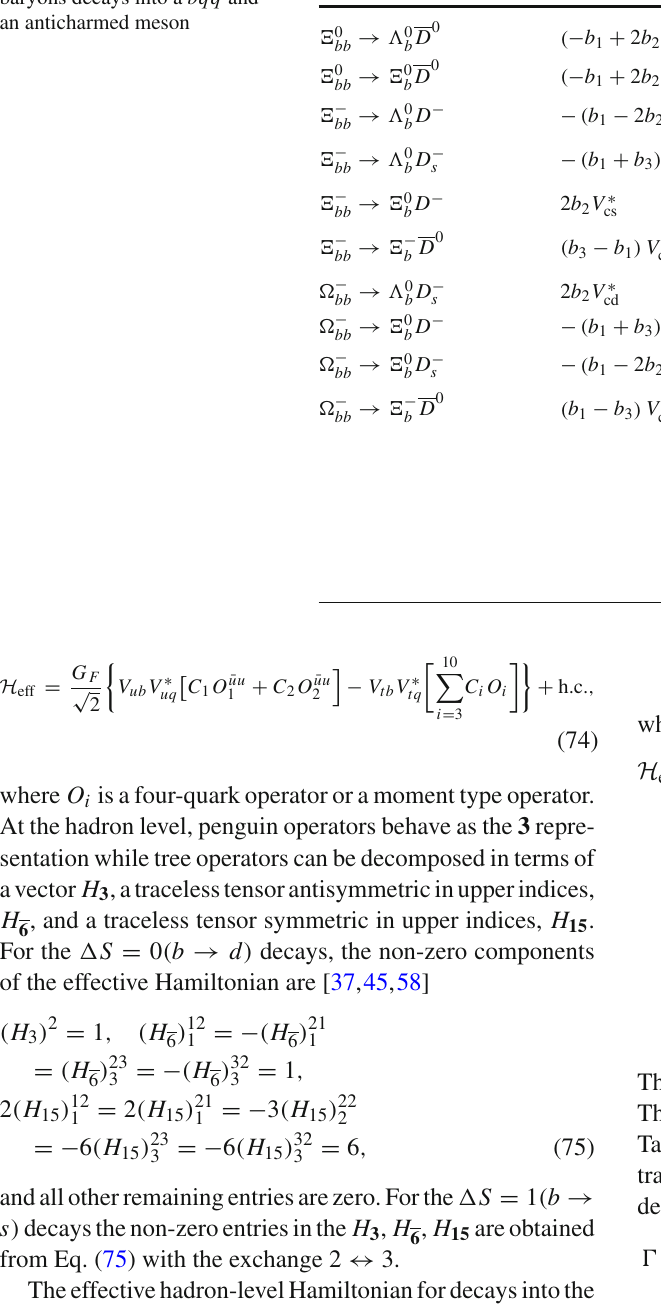
Table 16 Doubly bottom Channel Amplitude Channel baryons decays into a bqq and an anticharmed meson